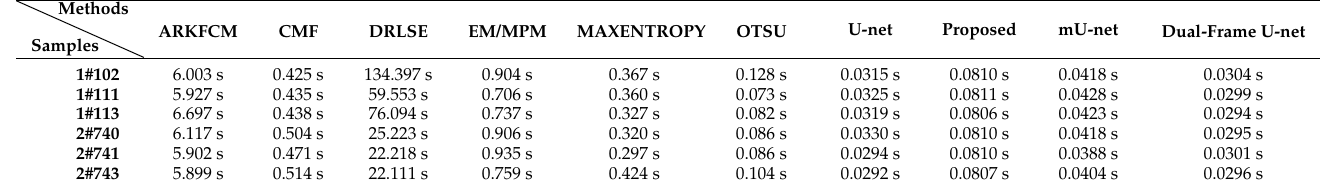
Table 5. Processing time of the proposed approach and the comparison